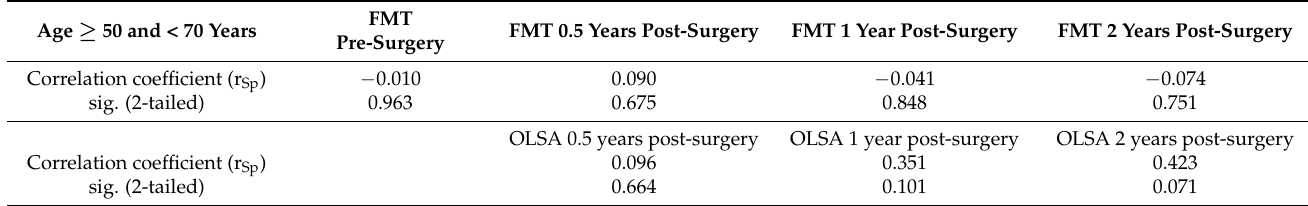
Table 4. Correlation analysis for speech perception and age in the mid-age group.